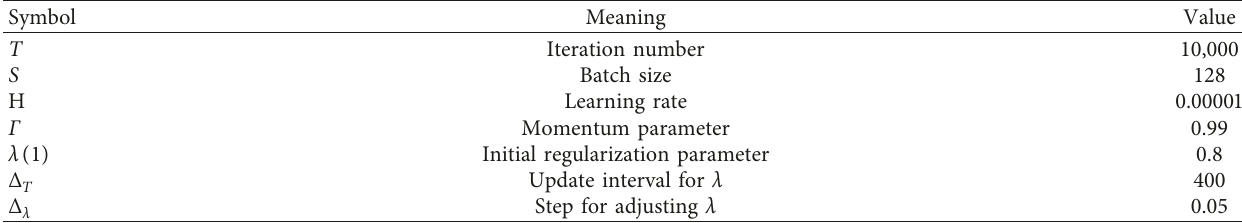
Table 1: Parameters used in the NN-based